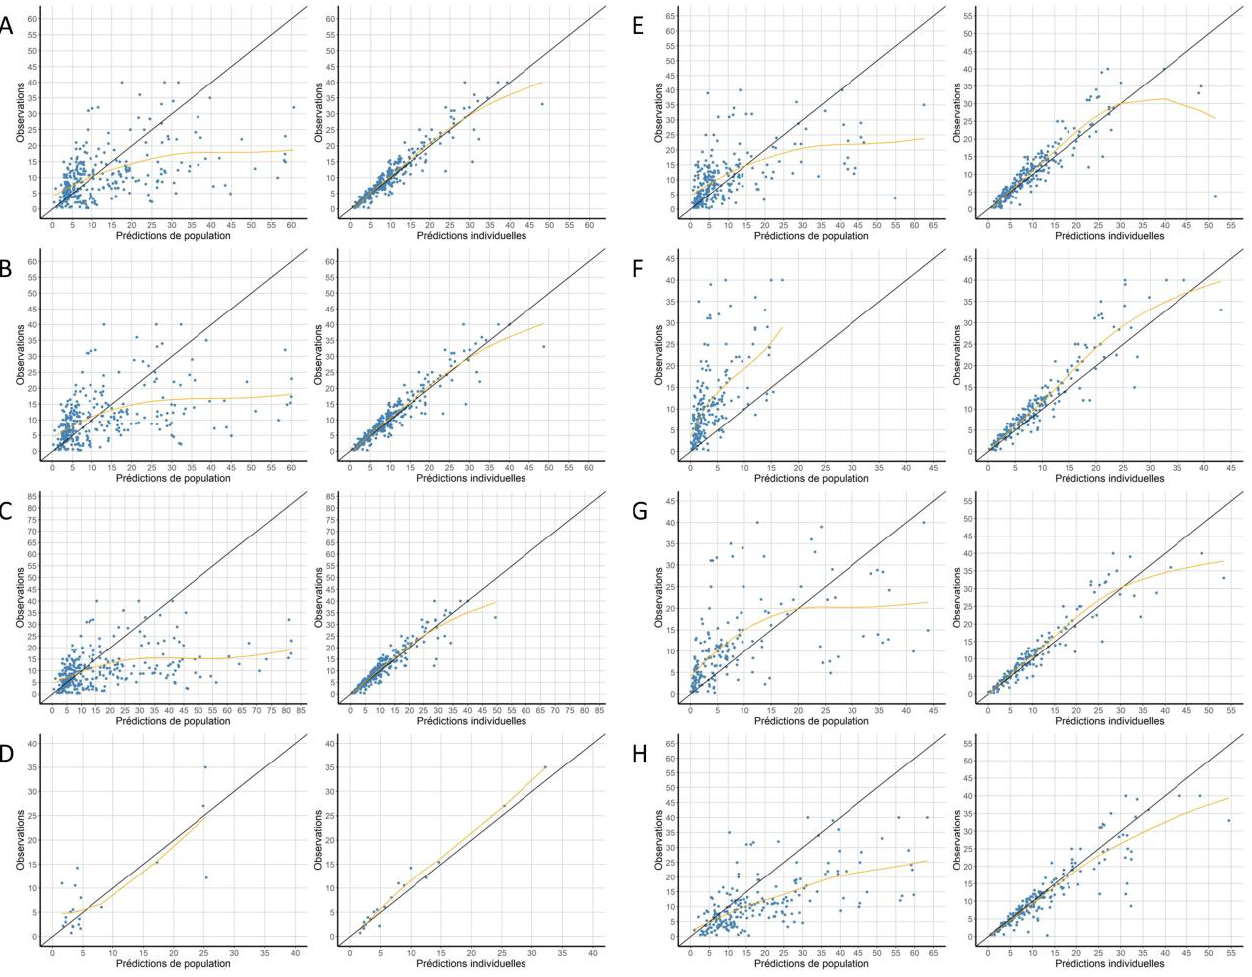
Figure 2. Graphs representing for each model ( A – H ) observations against population and individual predictions. The identity line is shown in black and a trend line (yellow) has been drawn for each model. Concentrations are shown in mg/L. Table 3. Comparison of population predictions (PPRED) and individual predictions (IPRED) to observations for the 8 evaluated models. Observations vs. PPRED Observations vs. IPRED Model